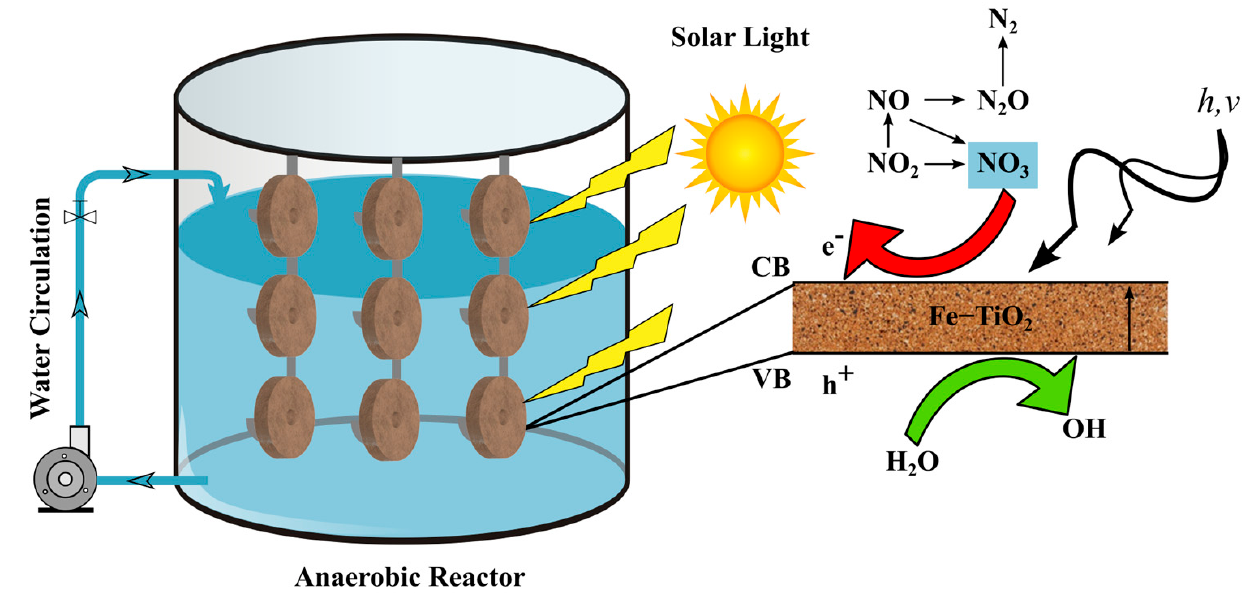
Figure 5. Proposed mechanism of the photocatalytic reduction of NO 3 using Fe-TiO 2 -coated filters.